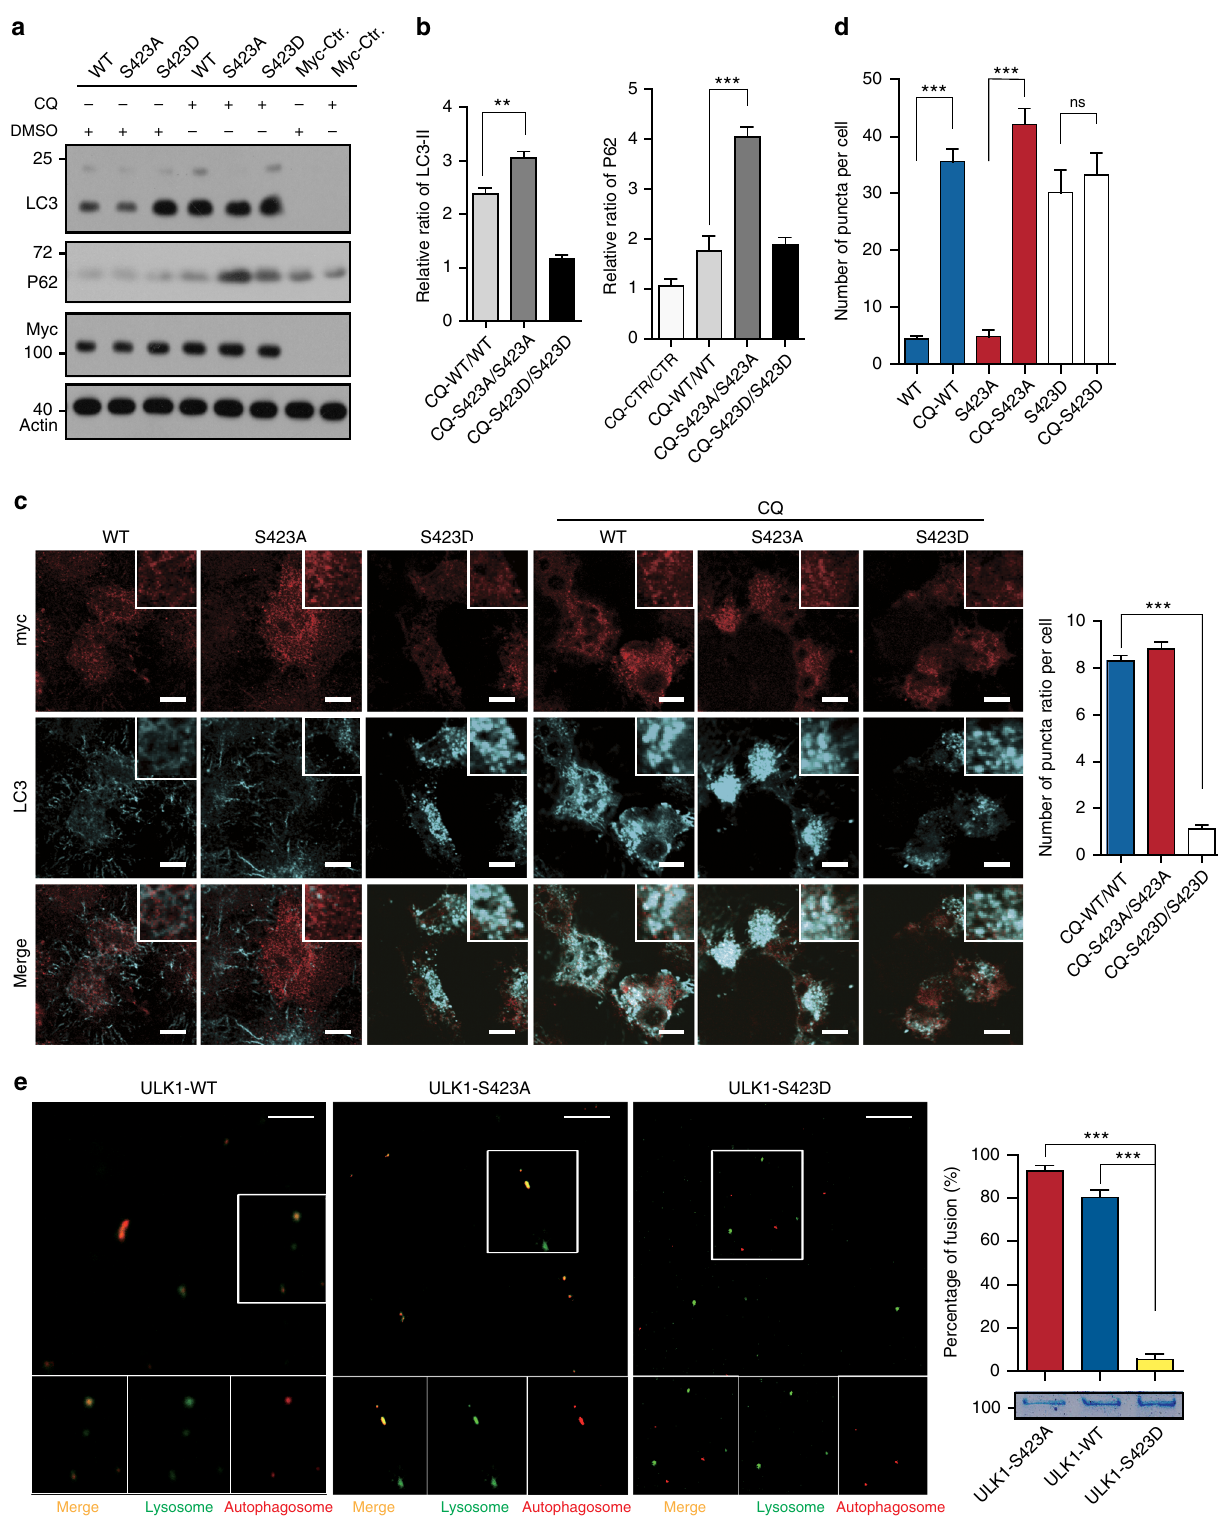
Fig. 3 Phosphorylation of ULK1 plays a key role in fusion of autophagosomes to lysosomes. a The control vector, ULK1 WT, S423A, and S423D were transfected into the ULK1/2-KO/D cells and treated with/out Chloroquine (CQ, an lysosomal inhibitor, 20 nM). The lysate was analyzed by WB with LC3, p62 and actin antibodies. b The quanti fi ed ratio (CQ-ULK1s/ULK1s) of LC3- Π and p62 is shown. c Representative confocal images of ULK1/2-KO/D HeLa cells transfected with Myc-ULK1 WT and mutants treated with/out CQ shown as the average of puncta per cell. Scale bar, 10 μ m. A minimum of 20 cells were counted. d The quanti fi ed ratio (CQ-ULK1s/ULK1s) of puncta per cell is shown. e Representative confocal images of in vitro fusion assay. Lysosomes (green) and autophagosomes (red) are mixed with puri fi ed GST-ULK1 WT, S423A, and S423D. Scale bar, 5 μ m. The fusion percentage was quanti fi ed by comparison of the number of yellow dots to the number of red dots and yellow dots. All values are means ± SEM of three independent experiments. Student ’ s t test (unpaired); NS: no signi fi cance; * p < 0.05, ** p < 0.01, and *** p <